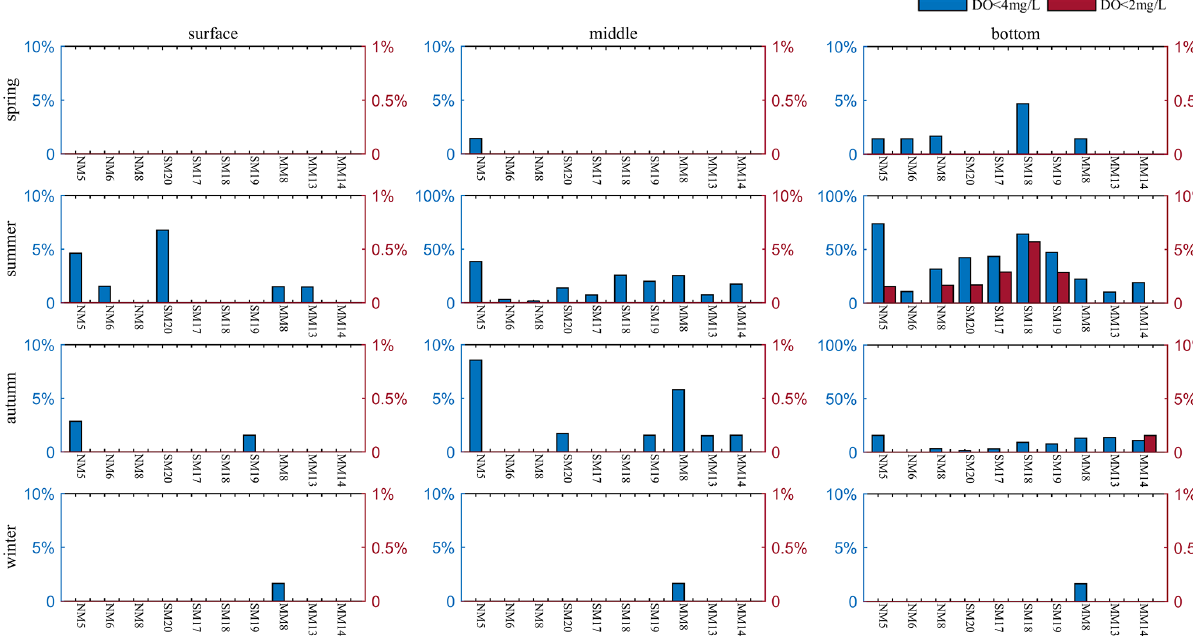
Figure A5. Frequencies of occurrence of low-oxygen and hypoxic events during four seasons in the surface, middle, and bottom